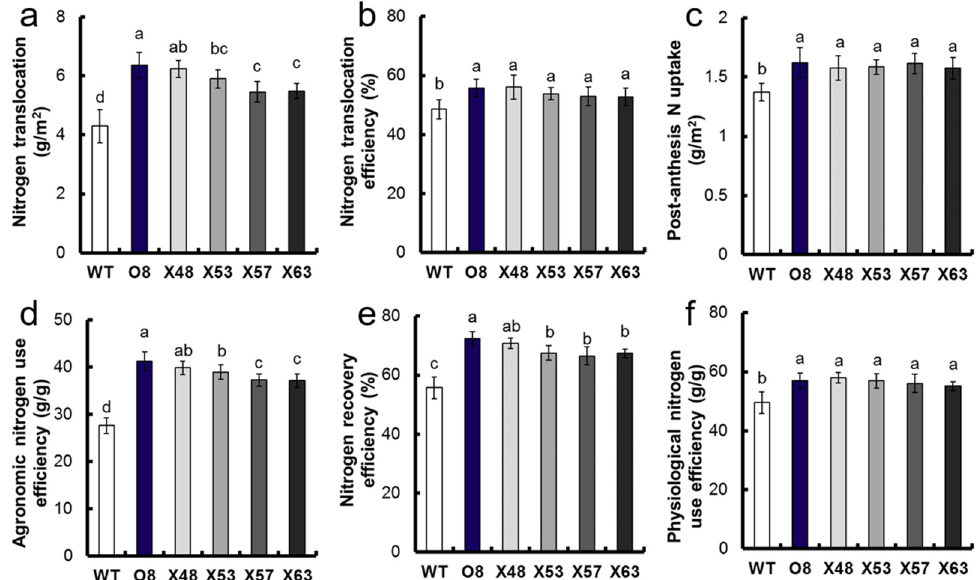
Figure 6. NUE of WT, O8, and EMS mutants in field plots . ( a ) N translocation, ( b ) N translocation efficiency, ( c ) post-anthesis N uptake, ( d ) agronomic N use efficiency, ( e ) N recovery efficiency, ( f ) physiological N use efficiency. Error bars: SE ( n = 3 plots). Significant differences between the WT and OsNRT2.3b overexpressing lines are indicated by different letters ( p < 0.05, one-way